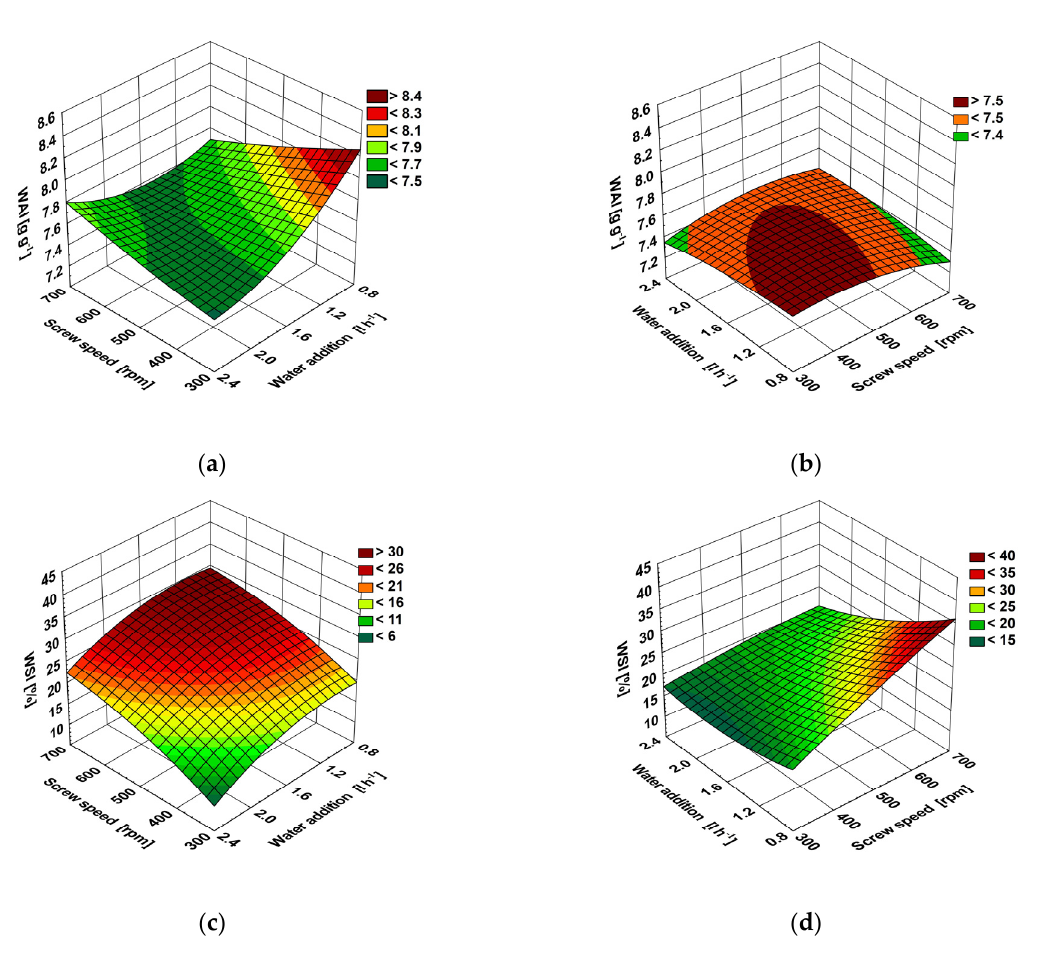
Figure 2. Effect of various extrusion parameters on WAI and WSI changes of extruded red beans ( a , c ) and white beans ( b , d ).